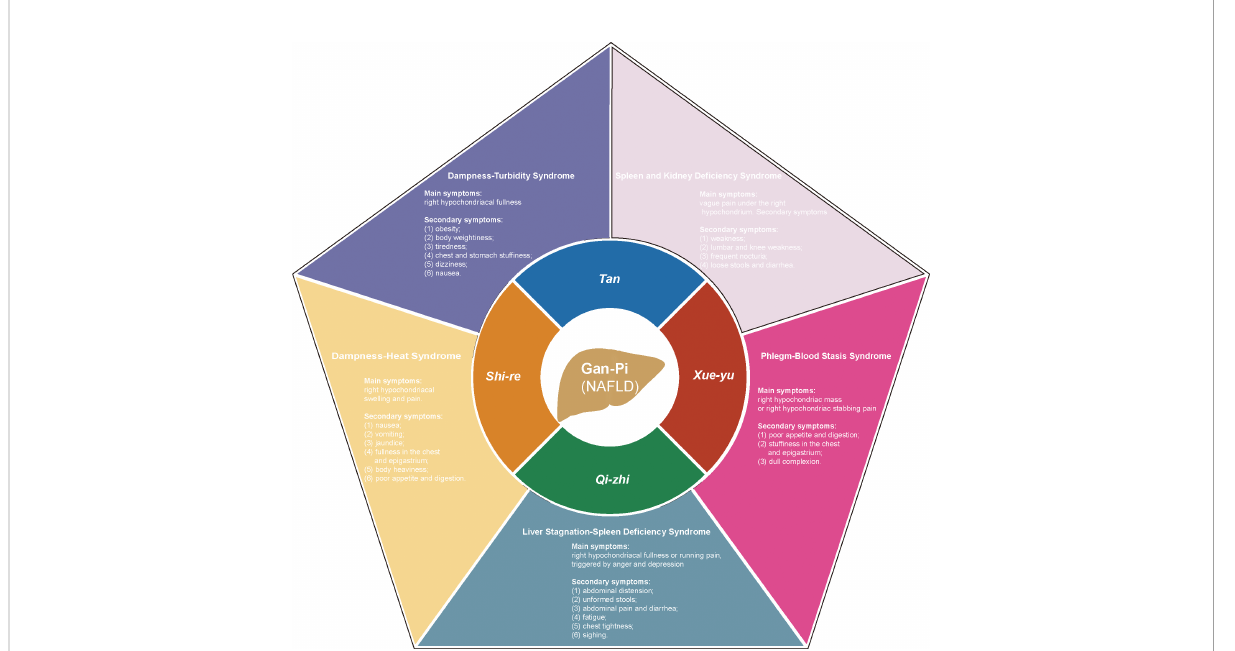
FIGURE 2 The pathological factors of Gan-Pi and the corresponding classi fi cation of symptoms of ZHENGs in TCM theory. dampness-heat (shi-re in Chinese), phlegm (tan in Chinese), blood stasis (xue-yu in Chinese) and qi stagnation (qi-zhi in